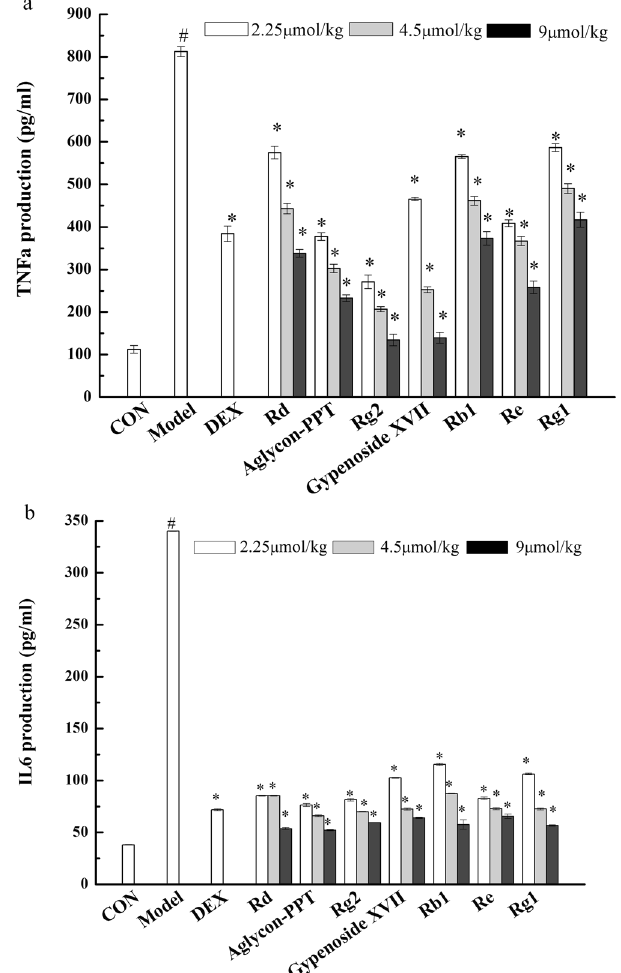
Figure 6. Effects of ginsenosides on protein productions of pro-inflammatory cytokines TNF- α ( a ) and IL-6 ( b ) in the xylene-induced ear swelling model. The data are means ± SD (n = 3). # p < 0.01 vs. the control group; * p < 0.001 vs. the model